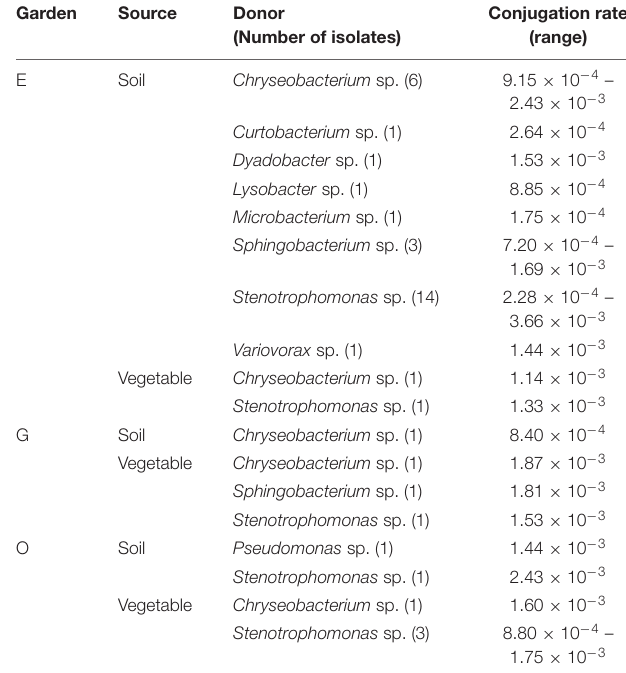
TABLE 1 | Conjugation results of 40 soil and vegetable isolates from three